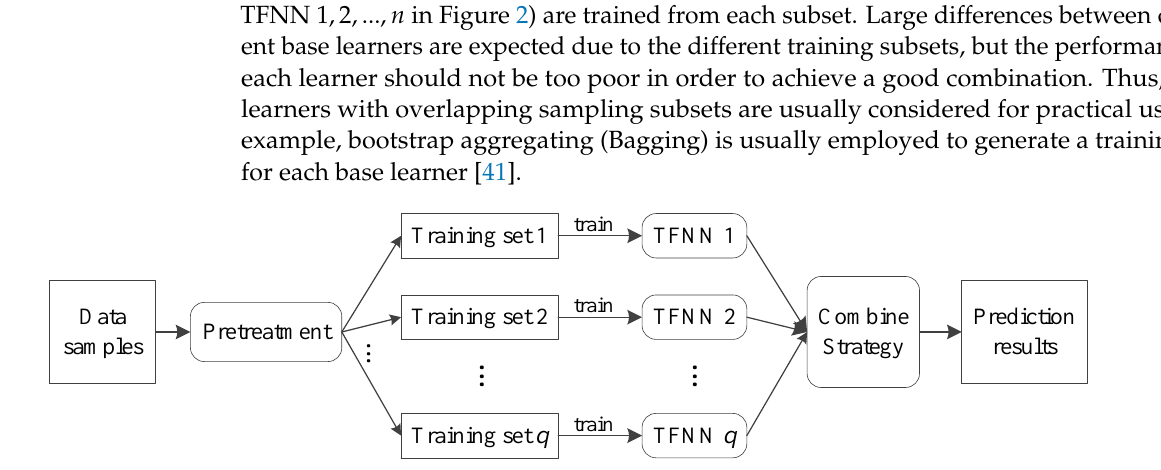
Figure 2. General procedure of ensemble